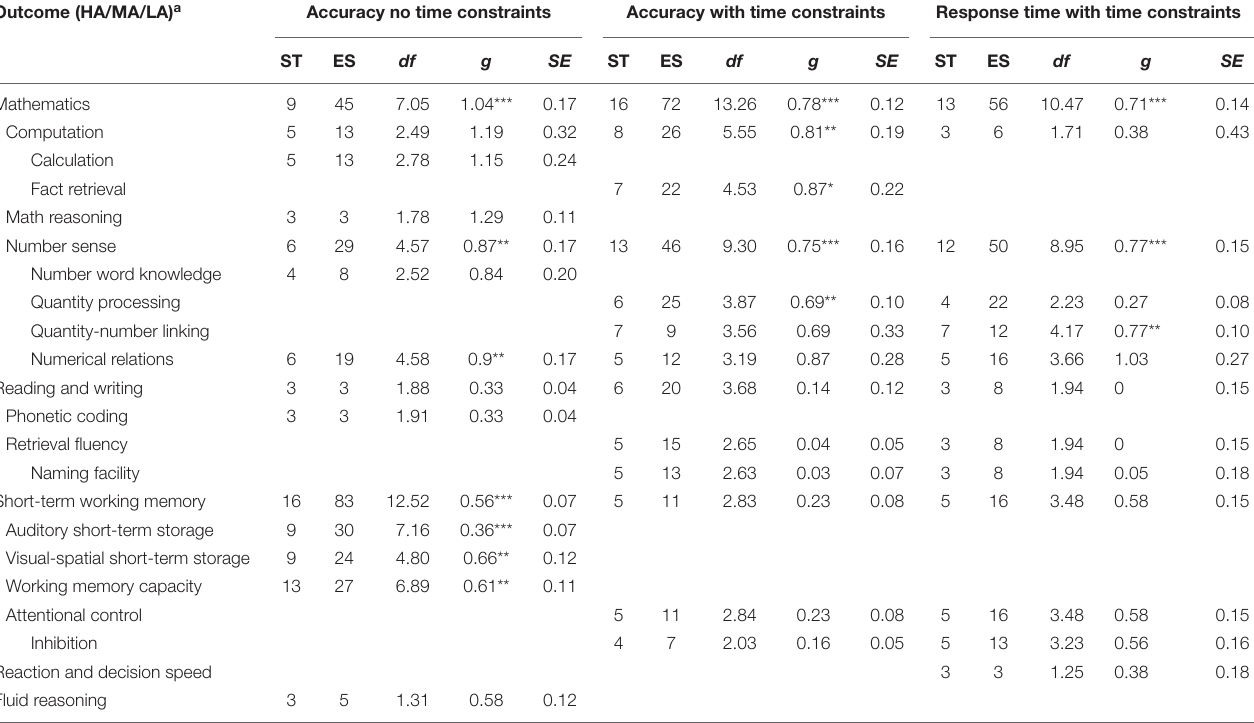
TABLE 2 | Results of random-effects model with RVE for data sets AC − TC, AC + TC, and RT + TC. Outcome (HA/MA/LA) a Accuracy no time constraints Accuracy with time